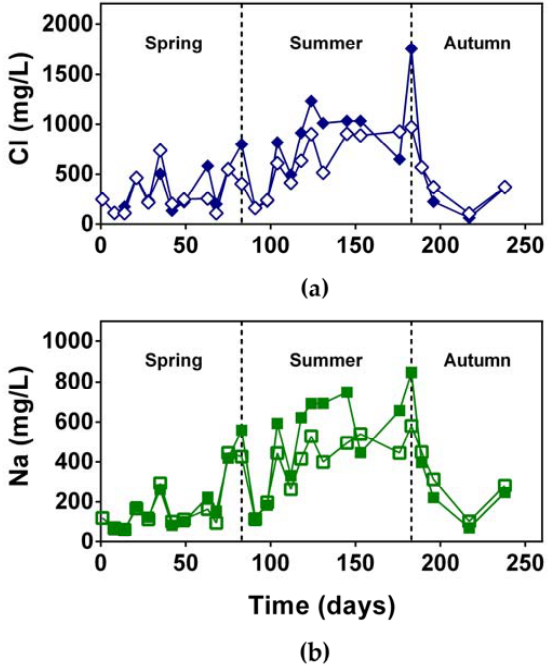
Figure 9. Concentration of Cl and Na in influent (S1) and effluent (S2) surface water along the monitoring performed in the pilot site from spring to autumn 2012: ( a ) Cl and ( b ) Na. Overall, the Cl and Na concentrations measured in influent water (S1) were high and ranged